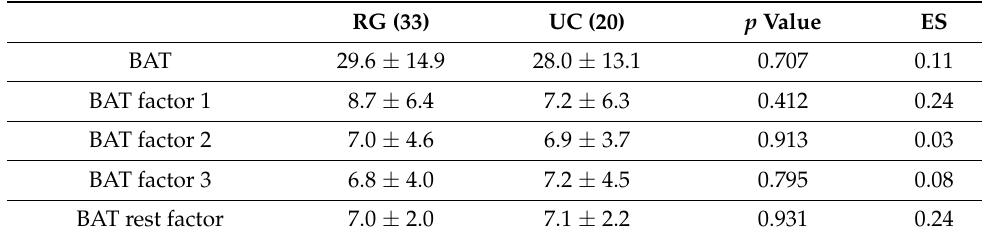
Table 3. BAT characteristics data in the RGs and UCs female groups.